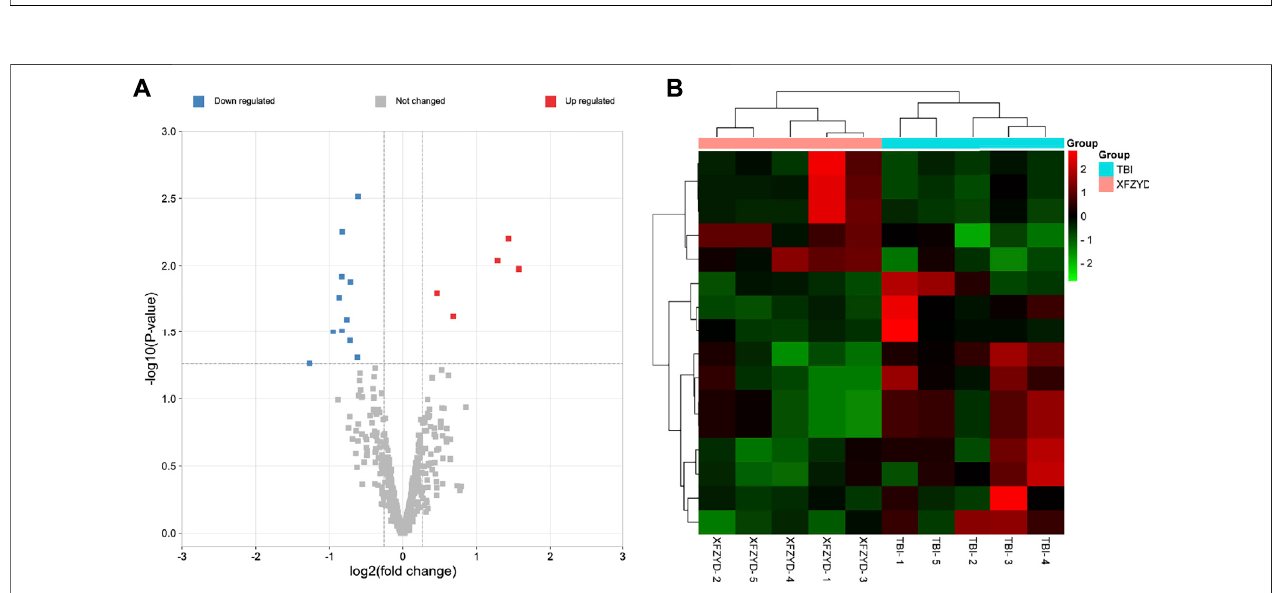
FIGURE 3 | (A) Volcano plot of distinctively expressed miRNA in XFZYD/TBI. The red dots represent upregulated miRNAs, and the blue dots represent downregulated miRNAs (log2(foldchange) > 0.3 and p -value < 0.05). (B) Hierarchical clusteringofDEMs inXFZYD/TBI. Ten sampleswere obtained from the TBI group and XFZYD group. Hierarchical clustering was formed based on miRNAs ’ expression levels. Green, downregulated; red, upregulated ( n = 5 mice per group). TBI: traumatic brain injury; XFZYD: Xuefu Zhuyu decoction.